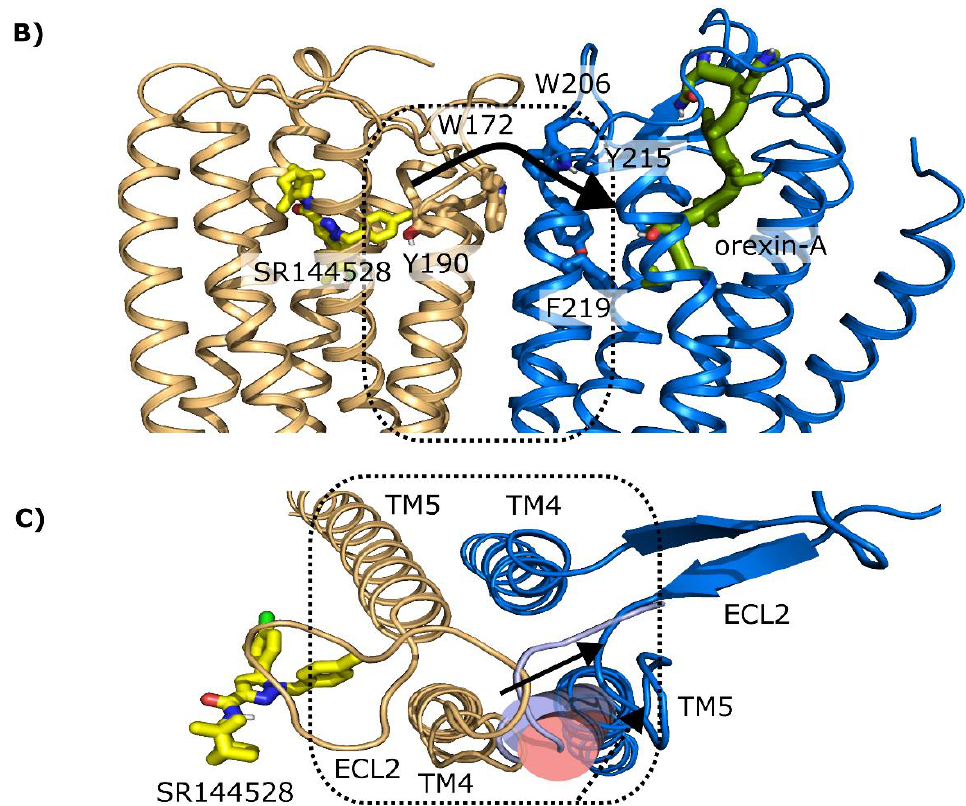
Figure 5. Computational model of the heteromeric TM4/5 CB 2 R-OX 1 R interface. ( A , B ) The possible modulation (indicated by the black arrows) of an antagonist to a neighbor receptor through a network of aromatic residues connecting both orthosteric sites, viewed from the membrane. ( A ) the CB 2 R/JWH133-OX 1 R/SB334867 complex; The experimental structure of the OX 1 R antagonist SB334867 revealed the presence of two copies of the ligand in the binding pocket interacting antiparallelly with each other, which resulted in a large ligand volume near TM5. ( B ) The CB 2 R/SR144528-OX 1 R/orexin-A. Similarly, the CB 2 R antagonist SR144528 puts an aromatic ring at the region where most CB ligands place the alkyl chain (such as in JHW133), also towards TM5. The CB 2 R receptor is shown in gold and the OX 1 R receptor in blue. Small-molecule ligands and aromatic side chains connecting the pockets are shown as sticks; orexin-A with a thick green cartoon. Dotted boxes indicate TMs 4 and 5 of both receptors. In ( C ) detail of the CB 2 R/SR144528-OX 1 R/orexin-A complex viewed from the extracellular side superposing different orientations of the extracellular portion of TM5 and proximal region of the second extracellular loop (ECL2) (i) from the OX 2 R/orexin-B complex (PDB id 7L1U, cylinder and loop in light blue), which would clash sterically with the TM4 of the CB 2 R; and (ii) from the OX 1 R/SB334867 complex (PDB id 6TQ7, pink cylinder), which orients in a direction that does not directly face TM4 and better avoids the possible clashes with it TM4. Arrows indicate the movements of TM5 helices towards the TM5 modeled in the heteromer (see Section 4, dark blue) [33]. This complex shows a characteristic signaling where the OX 1 R selective antagonist potentiates the cannabinoid CB 2 R function in cAMP signaling while it blocks the indirect MAPK pathway. These interesting results are also observed in resting microglia. However, in activated microglia, the OX 1 R antagonist blockade became stronger, inducing a higher potentiation of CB 2 R cannabinoid signaling not only in cAMP but also in MAPK signaling. These results can be explained because in primary microglia from the transgenic AD model, the CB 2 -OX 1 receptor heteromer expression is significantly higher than in equivalent cells from control animals, as shown by PLA. This finding suggests that the heteromer could be a target to combat neurodegeneration. We have previously shown that